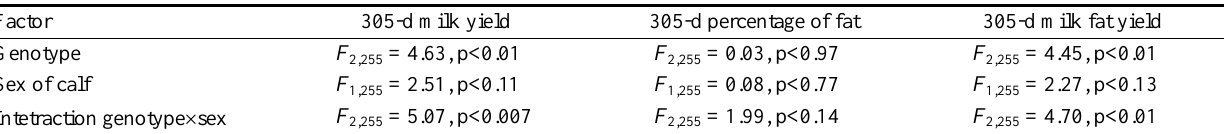
Table 1. Influence of genotype and sex of calf on milk performance traits in Black Pied cattle breed according to ANCOVA with number of lactation as a covariate